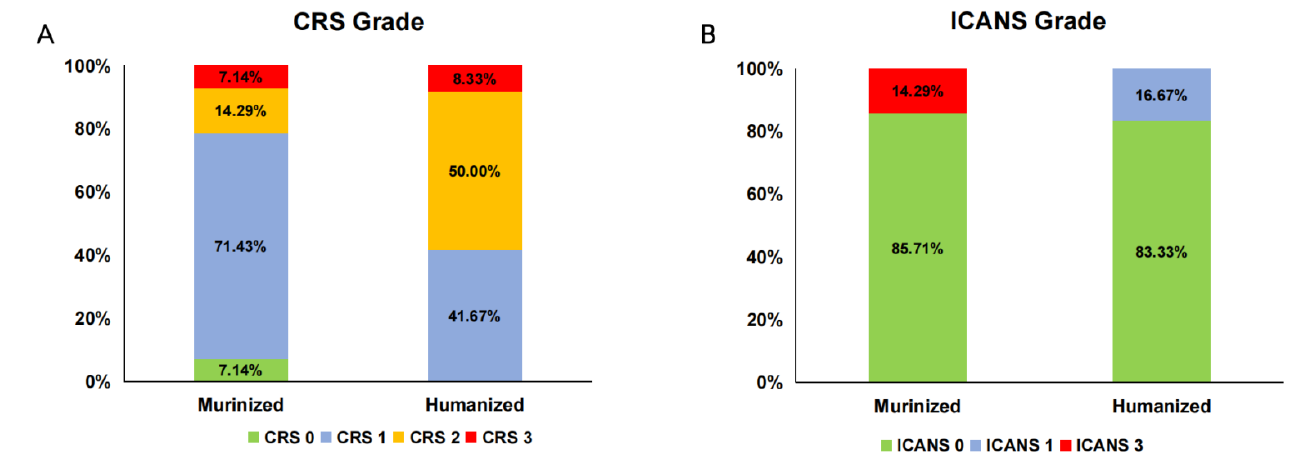
Figure 6. Comparison of CRS and ICANS between the murinized and humanized groups. Shown are the incidences of different grade CRSs ( A ) and ICANS ( B ) in the murinized and humanized groups. The majority of patients had mild CRS (grade 1–2) in both groups. Only 2 patients experienced grade 3 CRS, and 2 patients developed grade 3 ICANS. There was no significant difference in the incidence of CRS and ICANS between the two groups. CRS: cytokine release syndrome; ICANS: immune effector cell-associated neurotoxicity syndrome. Table 2. CRS, ICANS, and adverse events post CAR-T cells infusion. Murinized Group ( n = 14), No. of Patients (%) Humanized Group ( n = 12), No. of Patients (%) Any Grade Grade 3 Grade 4 Any Grade Grade 3 Grade 4